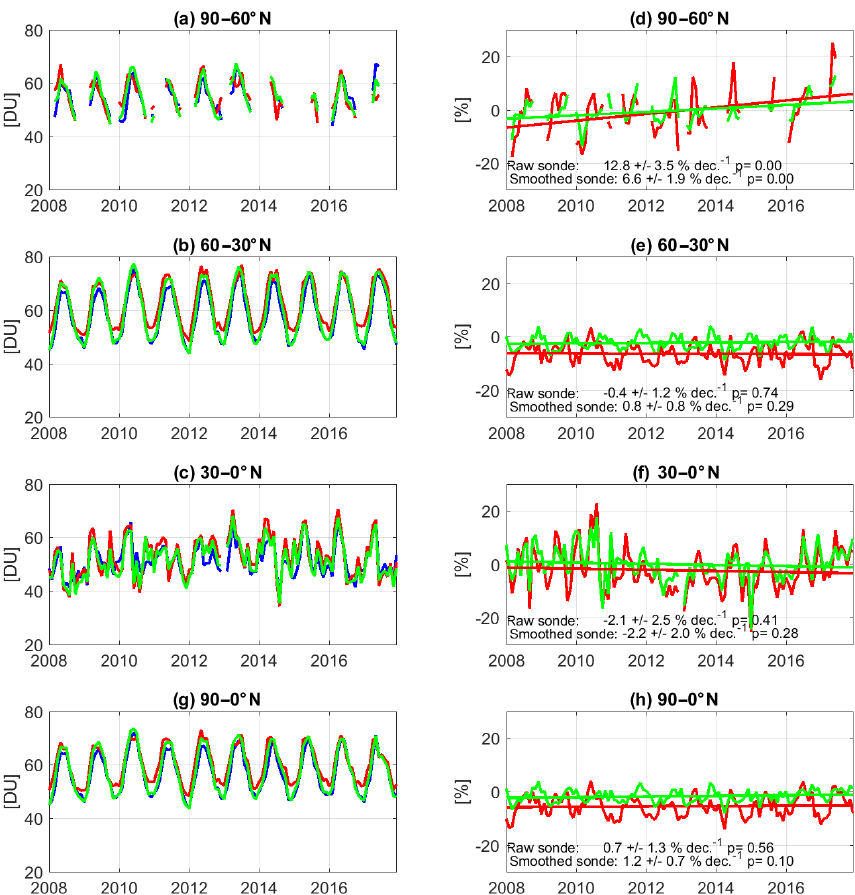
Figure 11. Same as Fig. 9 for SOFRID-O3 v3.5 in the Northern